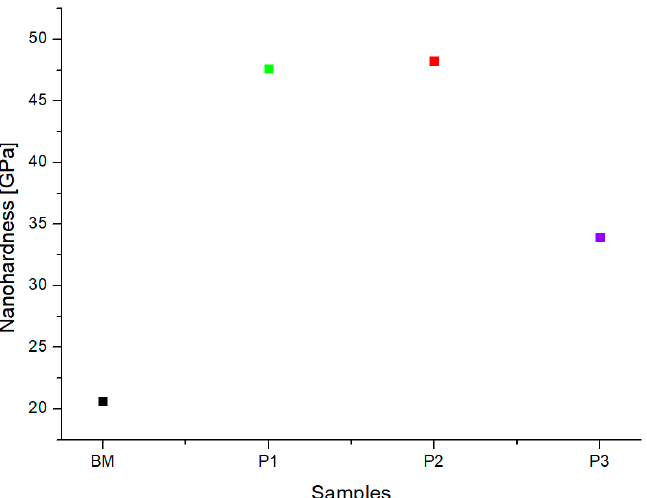
Figure 6. Nano-hardness of laser modified samples. BM: base material, P1: laser modified sample with 800 W and scan rate 60%, P2: laser modified sample with 800 W and scan rate 30%, P3: laser modified sample with 900 W and scan rate 60% [82].